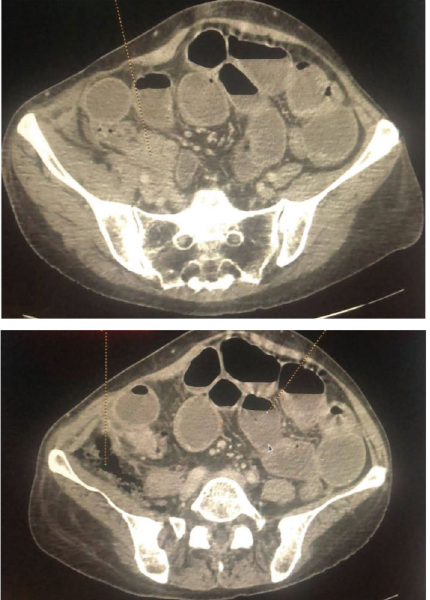
Figure 1: CT scan showing cecal tumor with small bowel distension and air in the retroperitoneal space.